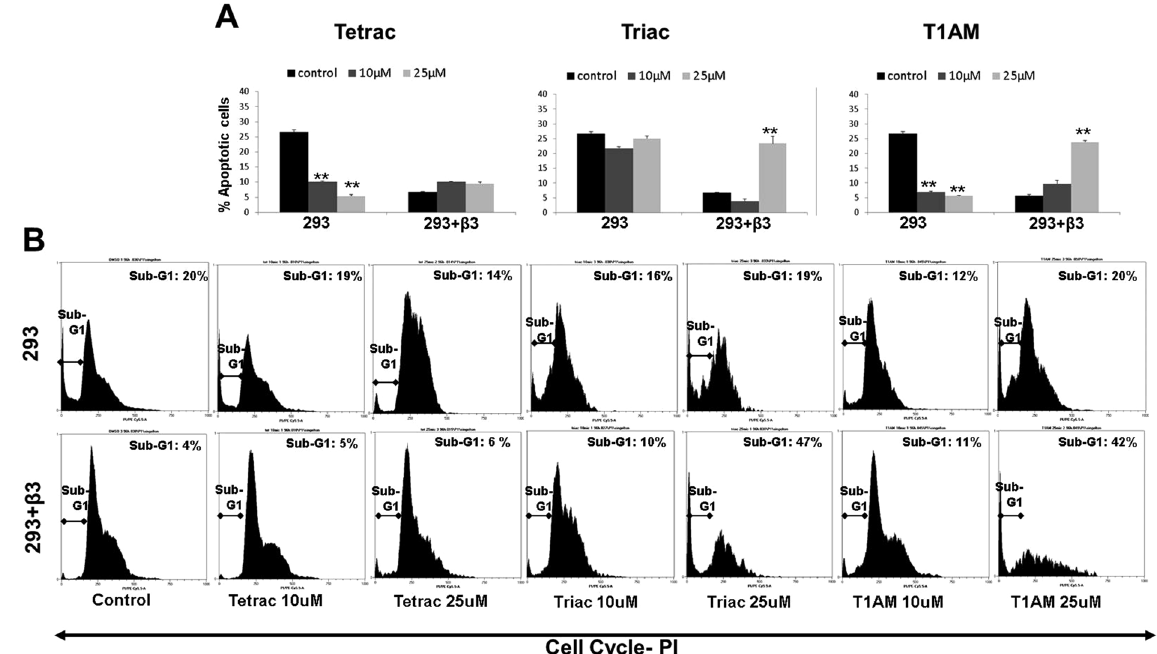
Figure 4. Triac and T1AM induce apoptosis in α v β 3-transfected HEK-293 cells. HEK-293 cells lacking or overexpressing α v β 3 integrin were treated in triplicates with 10 or 25 μ M tetrac, triac or T1AM for 96 hours and analyzed for ( A ) annexin-FITC/PI and ( B ) cell cycle distribution. Significance ( * p < 0.05, ** p < 0.005) from vehicle control (KOH) is